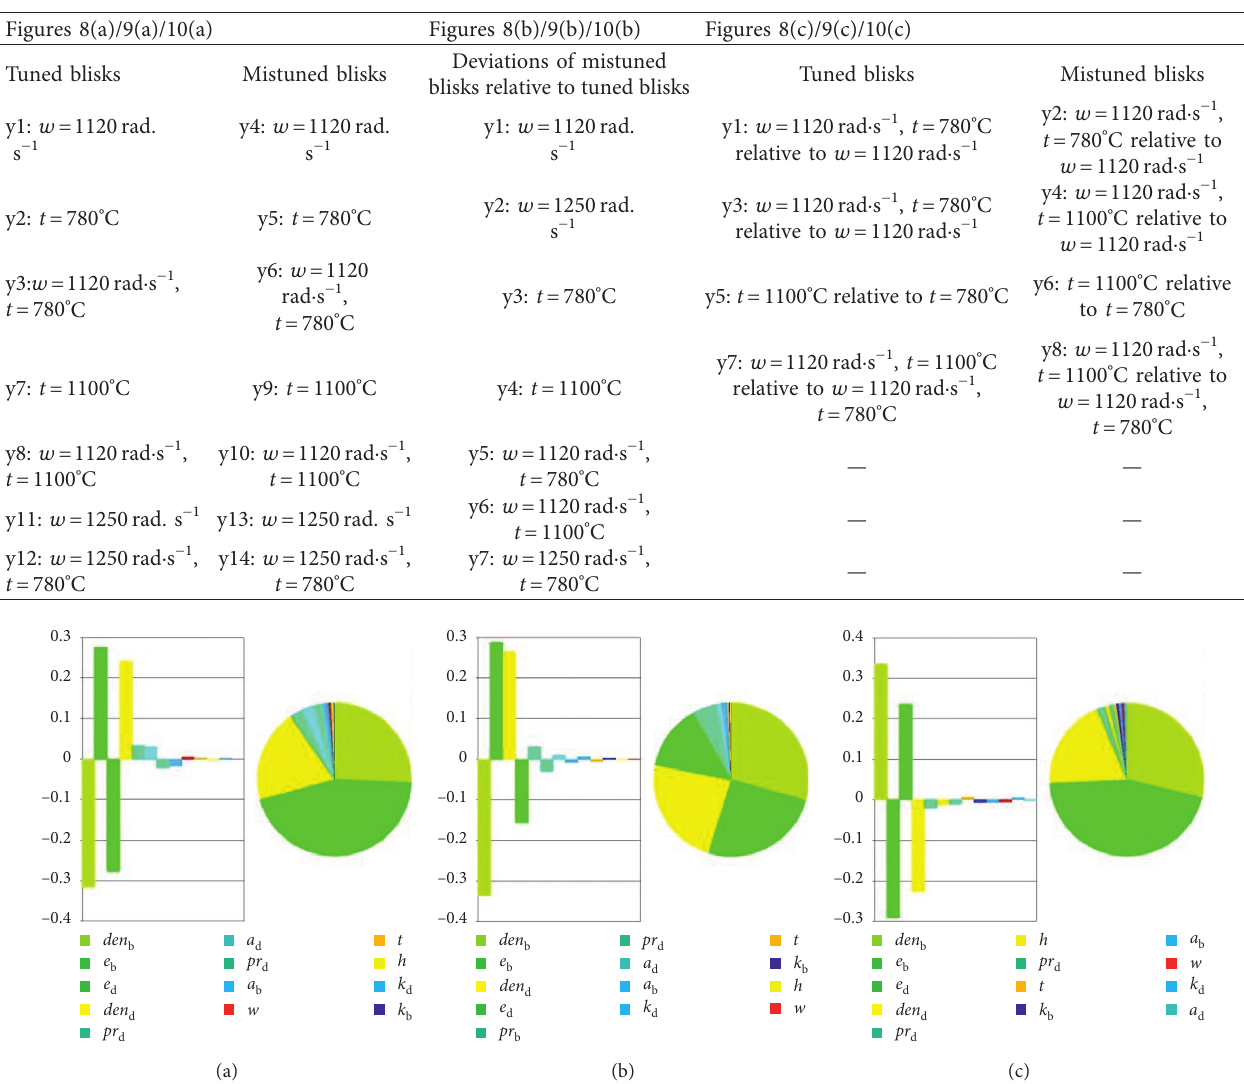
Table 4: The explanation of Figures 8–10.